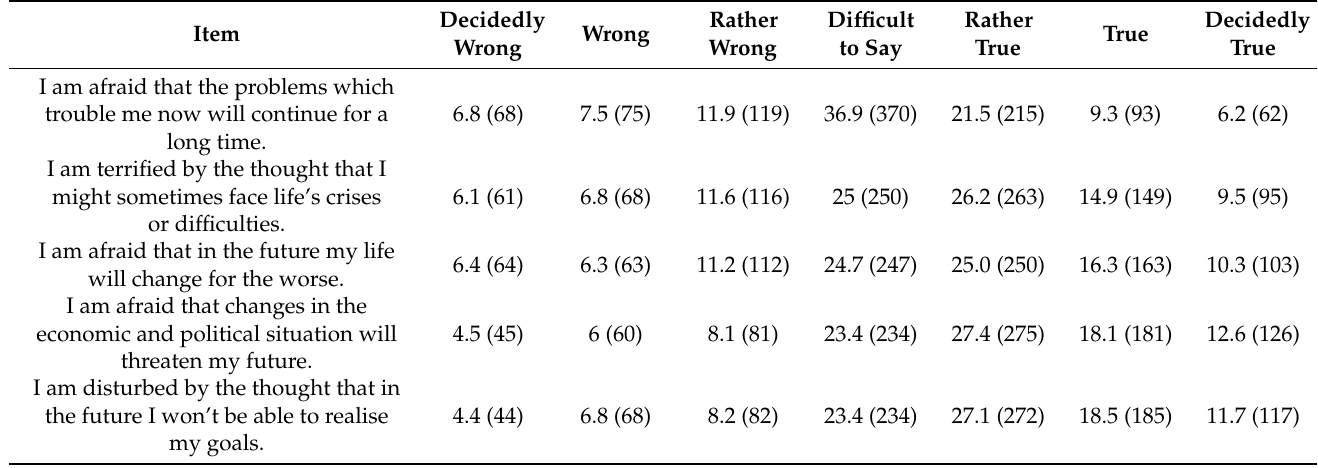
Table 1. The distribution of responses to the Dark Future